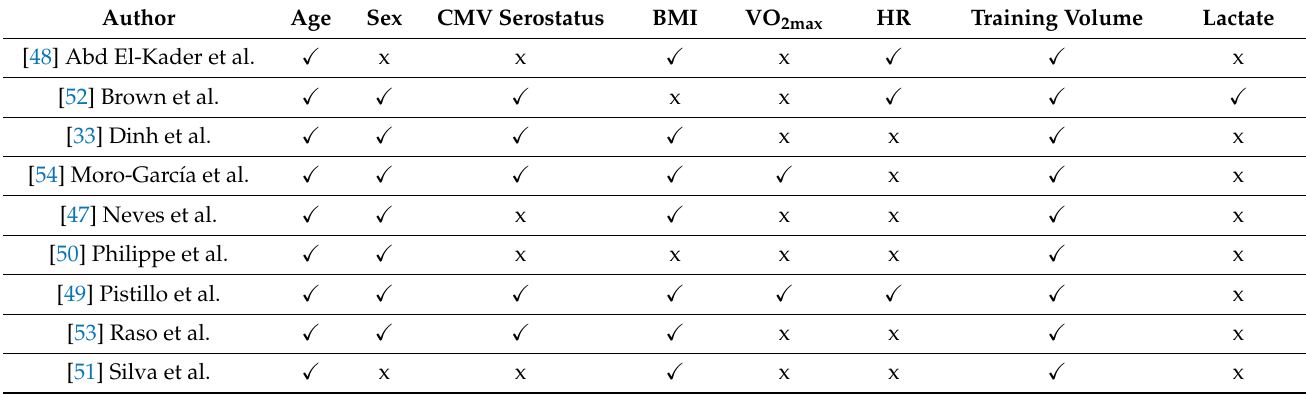
Table A2. Summary of selected investigated physical characteristics in each